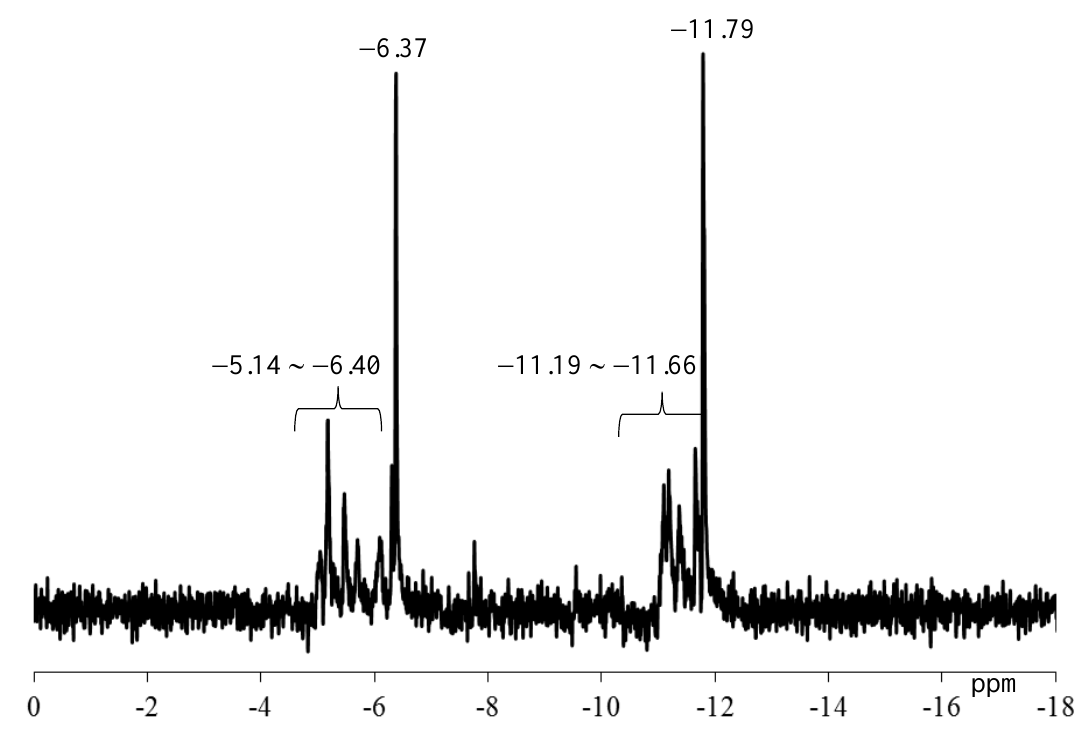
Figure 6. 31 P NMR spectrum in DMSO-d 6 of TBA-1 in the presence of a drop of water after standing for six days in DMSO-d 6 at approximately 25 ◦ C. The spectrum was referenced to an external standard of 85% H 3 PO 4 in a sealed capillary.